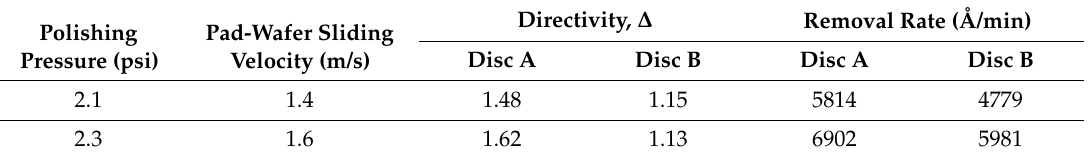
Table 1. Directivity and removal rate data for selected polishing